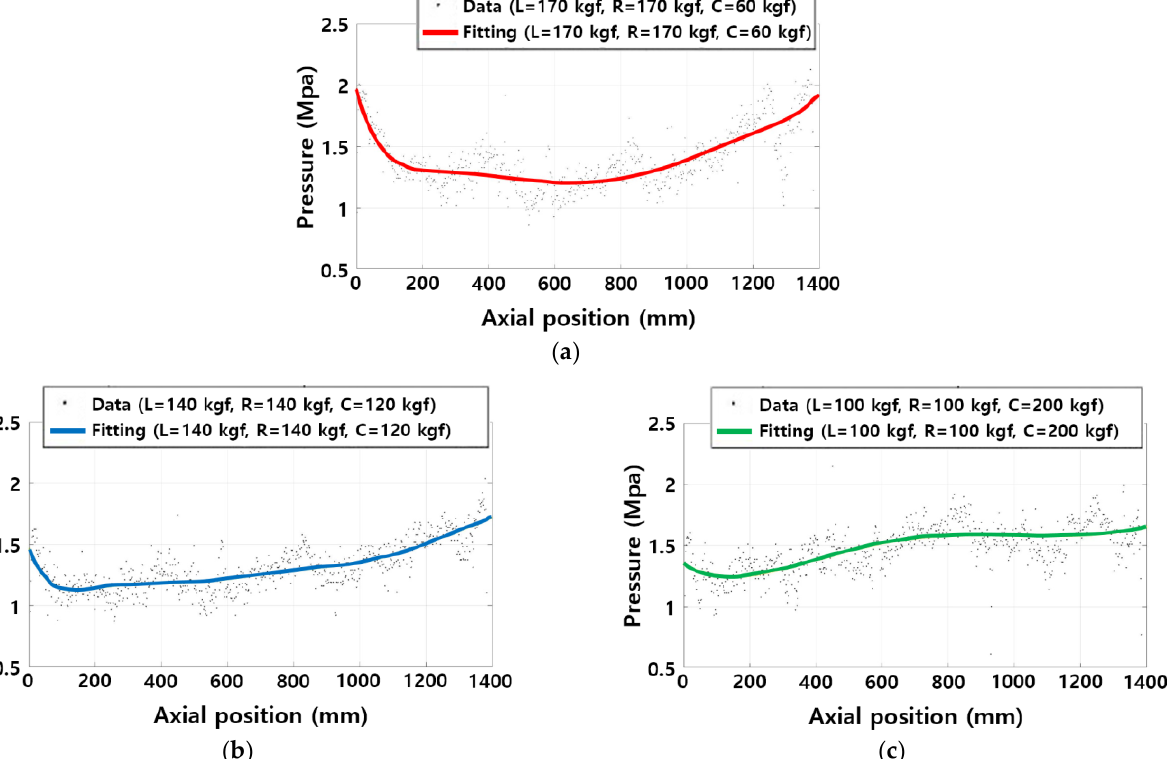
Figure 7. Pressure distribution along roller using center backup roller pressing: ( a ) Left force 170 kgf, right force 170 kgf and center force 60 kgf; ( b ) Left force 130 kgf, right force 130 kgf and center force 140 kgf; ( c ) Left force 100 kgf, right force 100 kgf and center force 200 kgf.